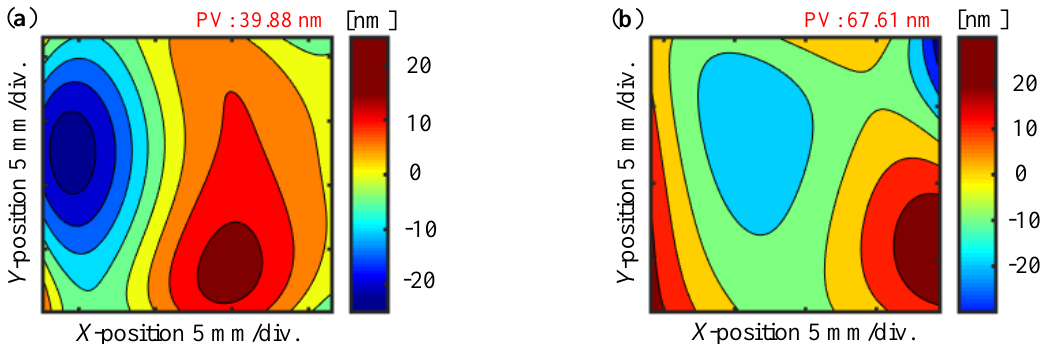
Figure 11. Measurement and fitted results of the X - and Y -directional pitch deviations. ( a ) X -directional pitch deviation of polynomial fitted results; ( b ) Y -directional pitch deviation of polynomial fitted results.